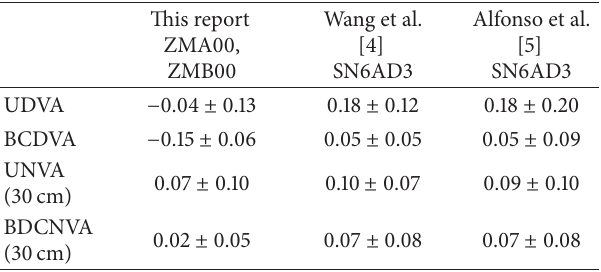
UDVA, uncorrected distant visual acuity; BCDVA, best corrected visual acuity; UNVA, uncorrected near visual acuity; BDCNVA, best distance- corrected near visual